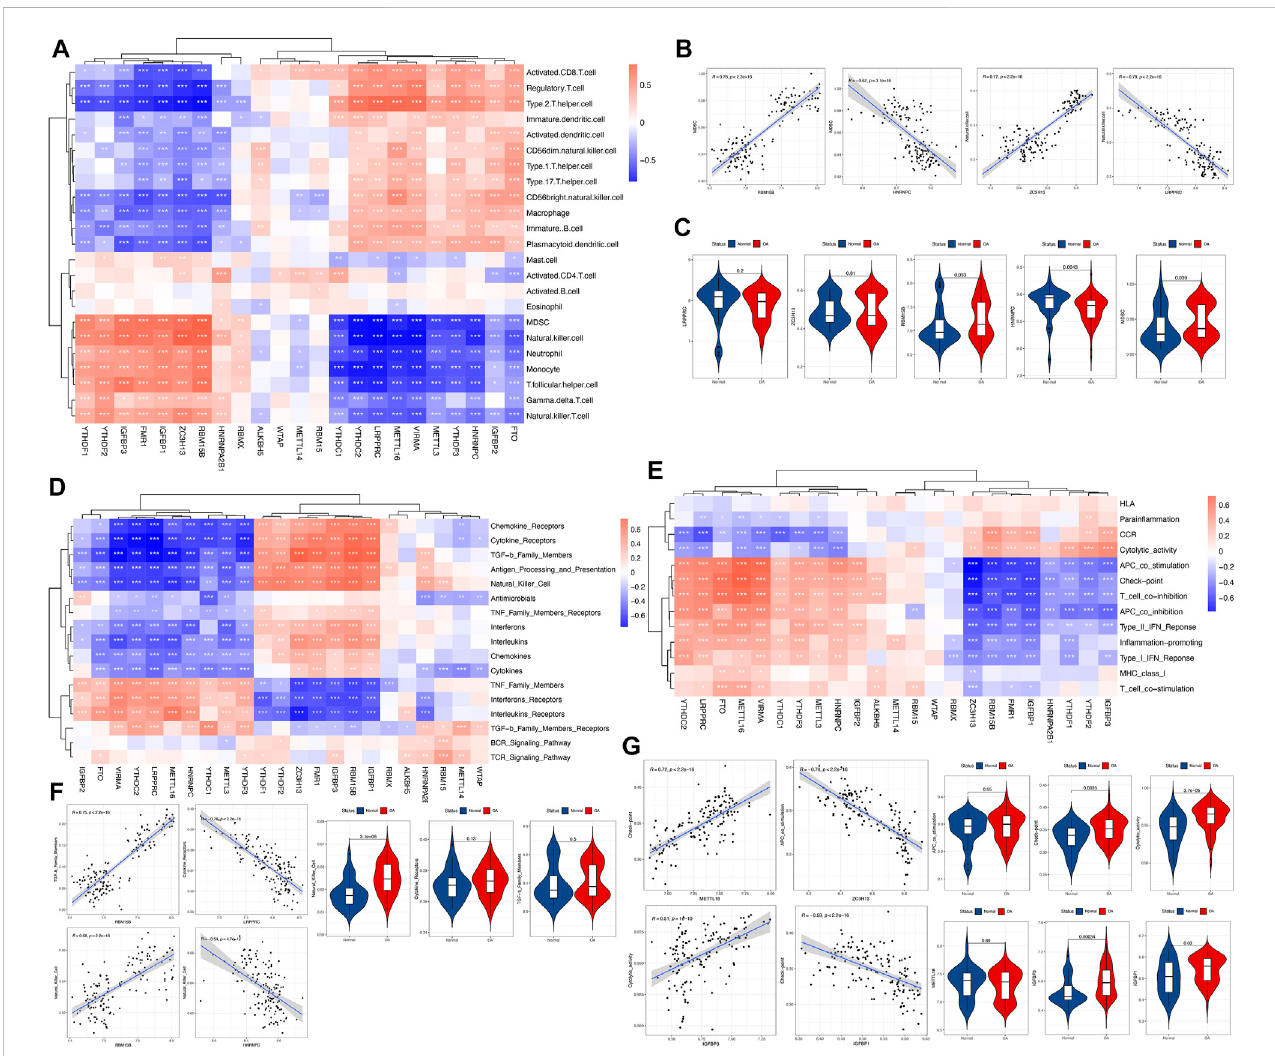
FIGURE 3 Correlations between the immune cell in fi ltration fraction, immune response gene sets, immune function gene sets, and m 6 A regulators. (A) Heatmap demonstrating the correlations between each immune in fi ltration cell type and each m 6 A regulator. Red indicates a positive correlation, and blue indicates a negative correlation. (B,C) Scatterplot demonstrating the correlations between the dysregulated immune cell fraction and the m 6 A regulator. The fraction or expressionstatusispresentedasaviolinplot,indicatingthatthereweremoreMDSCs,higherexpressionofRBM15B,andlowerexpressionofHNRNPCin osteoarthritis. (D,F) Heatmap demonstrating the correlations between each immune response gene set and each m 6 A regulator. For dysregulated m 6 A regulators, the most positively correlated pair was natural killer cell-RBM15B, and the most negatively correlated pair was natural killer cell-HNRNPC. There was a more active natural killer cell reaction in osteoarthritis, as presented by the violin plot. (E,G) Heatmap demonstrating the correlations between each immune function gene set and each m 6 A regulator. For dysregulated m 6 A regulators, pairs with a stronger positive correlation were cytolytic activity-IGFBP3, whereas a negative correlation was found for check-point-IGFBP1, and there were stronger check-point and cytolytic activity functions activated in osteoarthritis, as presented by the violin